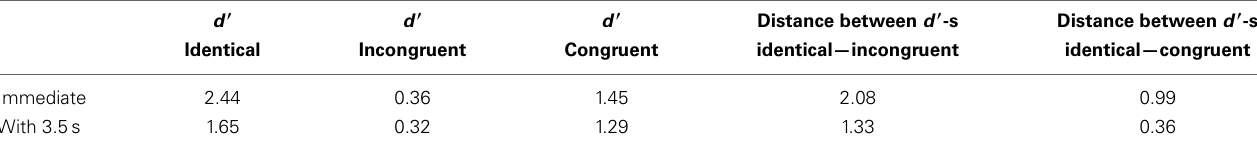
Table 4A | The d (cid:2) -values based on pooled replies for the stimulus-pairs containing tones with identical timbres (first column), with different timbres at “incongruential” timbral order (second column), with “congruential” timbral order (third column), as well as the distances between corresponding d (cid:2) -s (in d (cid:2) units).